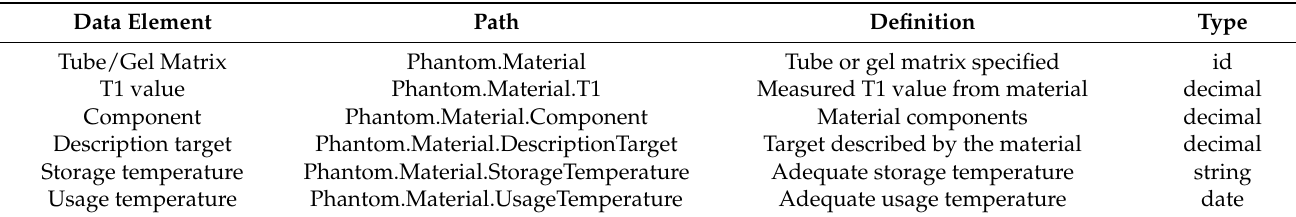
Table 7. Example of Tube, Gel Matrix Element Profiling within Phantom